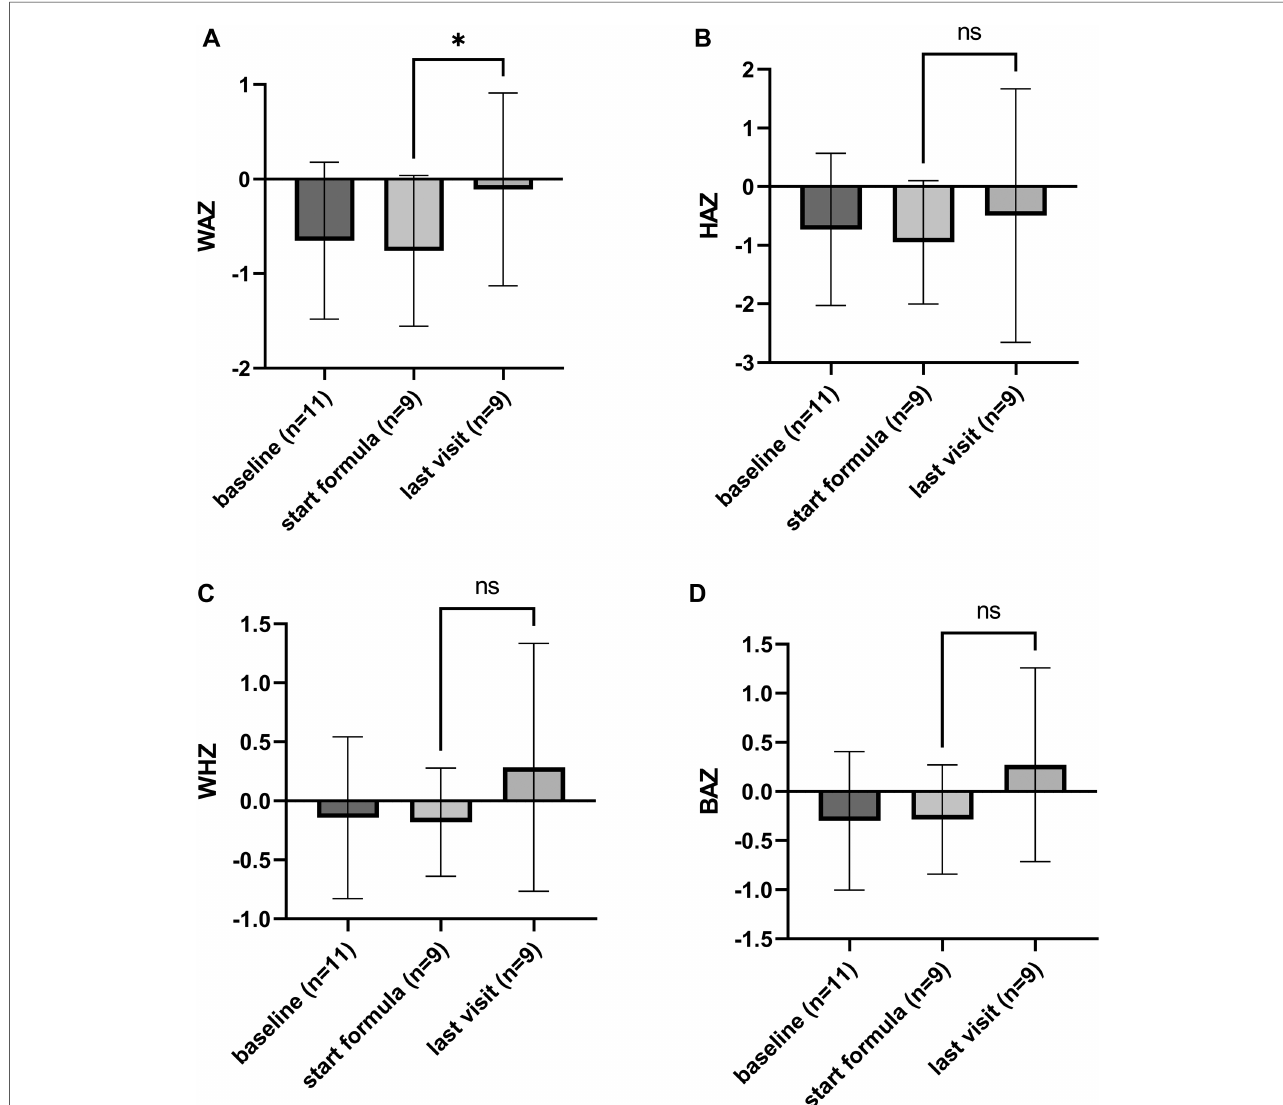
FIGURE 2 Growth outcomes of the study subjects consuming eHF-W, presented as Z -scores (mean±SD, with individual scores); ( A ) weight-for-age, ( B ) height-for-age, ( C ) weight-for-height, and ( D ) BMI-for-age Z -scores. Weight-for-age (WAZ) signi fi cantly improved during formula consumption ( p